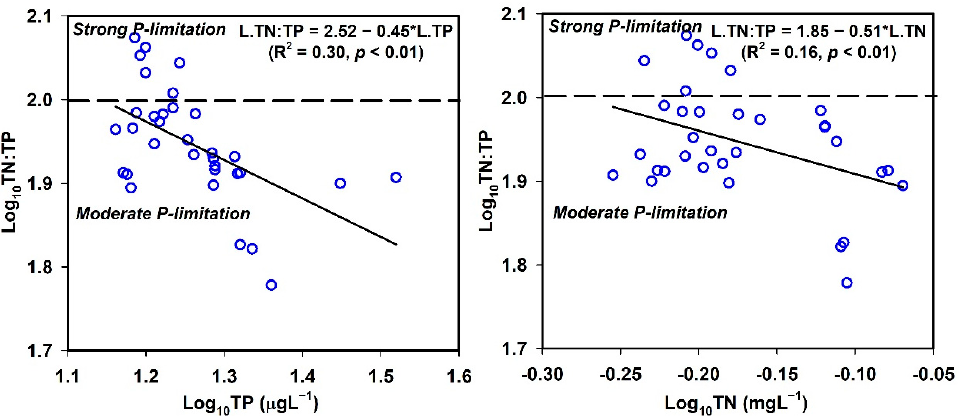
Figure 6. Relationships between TN:TP ratio, TP, and TN. (TP: total phosphorus; TN: total nitrogen).